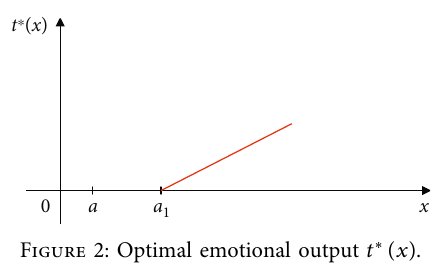
Figure 2: Optimal emotional output t ∗ ( x ) .